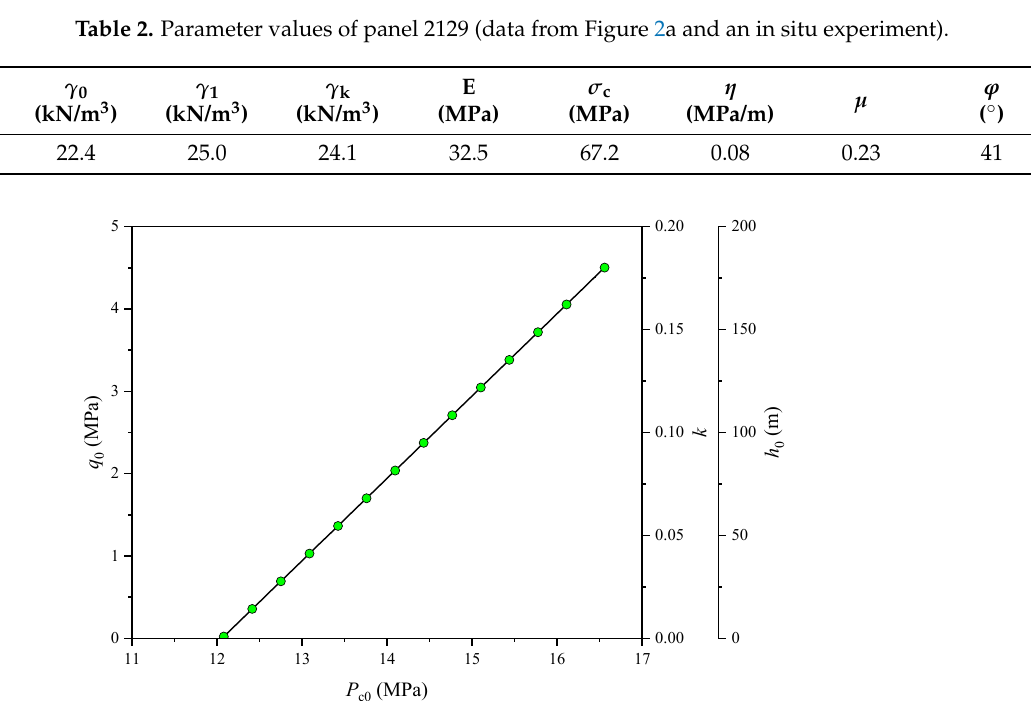
Figure 4. Relationship between critical water pressure ( P c 0 ) and the caved goaf overburden load ( q 0 ), stress recovery coefficient ( k ) and height of the caved zone ( h 0 ) (a = 93 m).